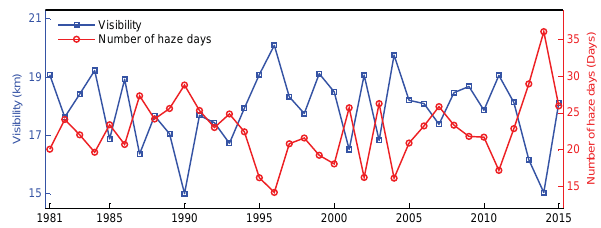
Figure 2. Curves of the winter mean visibility and number of hazy days in